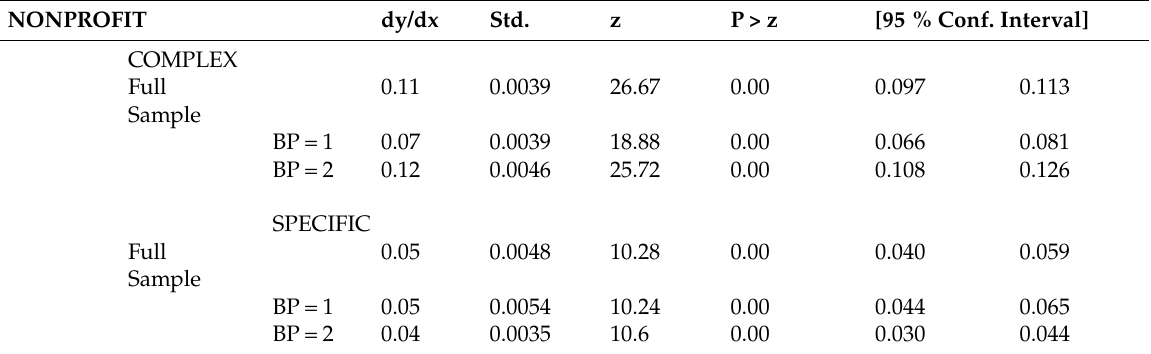
Table 8: Predictive margins for